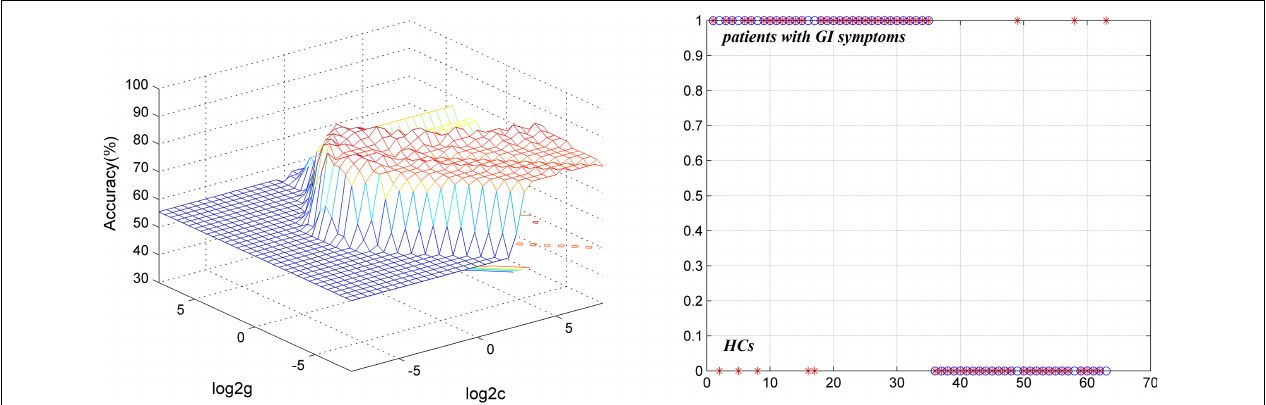
FIGURE 6 | Visualization of classifications through SVM using a combination of GFC values of the left PCC/Pcu and bilateral MTP to discriminate MDD with GI symptoms and HCs. (Left) SVM parameters result of 3D view. (Right) Classified map of a combination of GFC of the left PCC/Pcu and bilateral MTP. SVM, support vector machine; GFC, global functional connectivity; HCs, healthy controls; PCC/PCu, posterior cingulate cortex/precuneus; MTP, middle temporal pole; MDD, major depressive disorder; GI, gastrointestinal